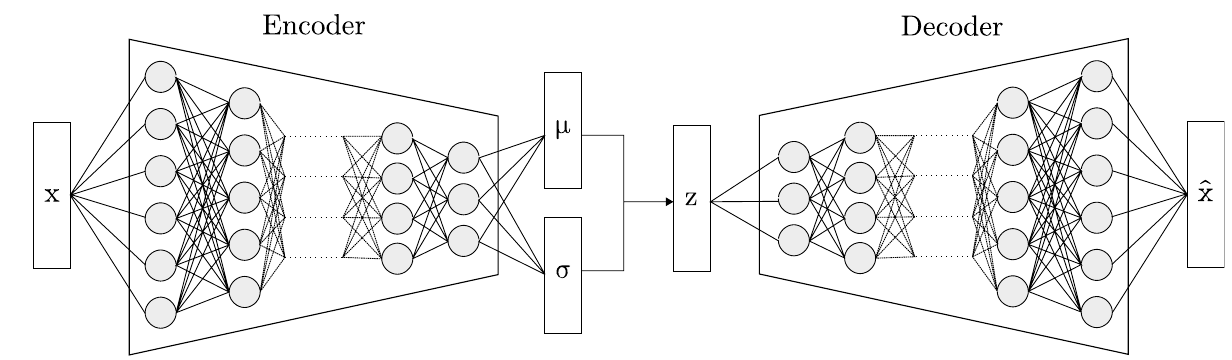
Figure 1. VAE: The data is first passed through an encoder network to output the mean and variance of the latent distribution of the data. Then we sample from this distribution to obtain a candidate latent space. This candidate latent space is then mapped back to an approximation of the original data using a decoder